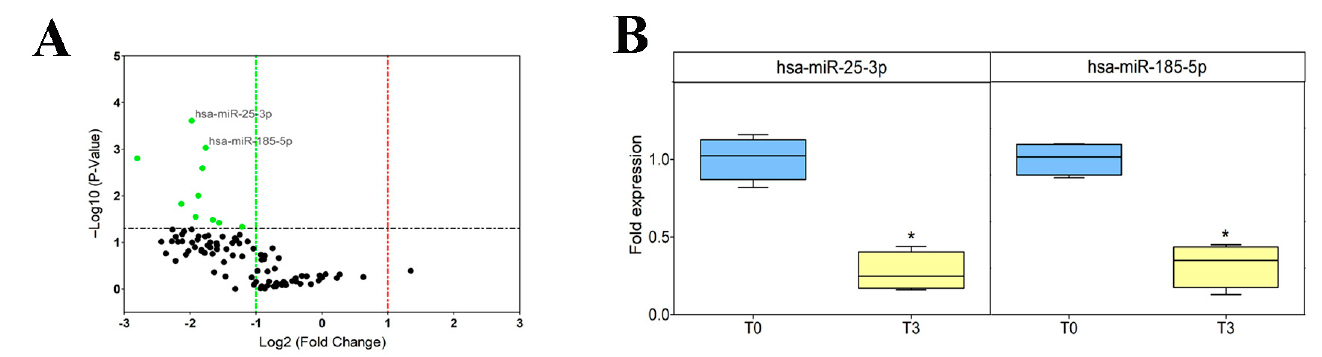
Figure 4. ( A ) Volcano plot of the 98 serum miRNAs analyzed by qRT-PCR (T3 vs. T0). Significant down-regulated miRNAs are localized in the upper-left section (dots colored green). ( B ) Serum miR-25-3p and miR-185-5p levels at T3 compared to baseline. Values are represented in whiskers plots as fold expression. Statistical significance is indicated at the top of the graph. * p ≤ 0.05. Table 2. Serum miRNAs differentially expressed in patients after treatment (T3) compared to baselines (T0). Bold characters indicate significant p -values both at a nominal level and adjusted for multiple testing. Differences between two groups (T3 vs. T0) were analyzed by paired two-tailed t -test, followed by Benjamini–Hochberg